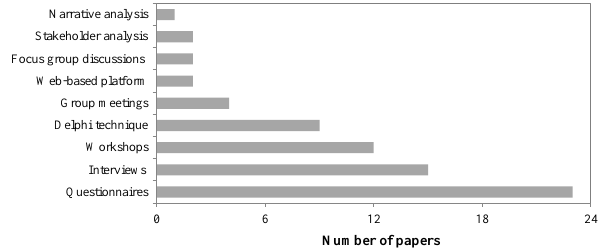
Figure 4. Methods used to incorporate multiple stakeholders’ views in the decision-making